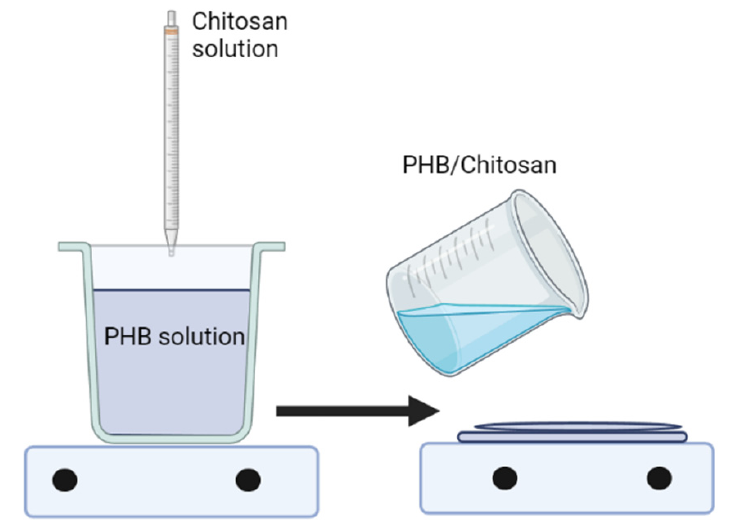
Figure 7. A method of casting polymer